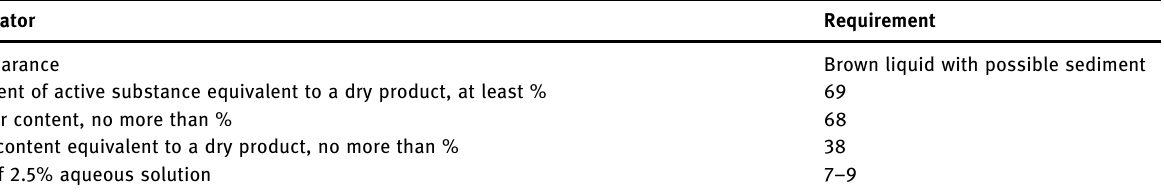
Table 6: Requirements for superplasticizer C - 3